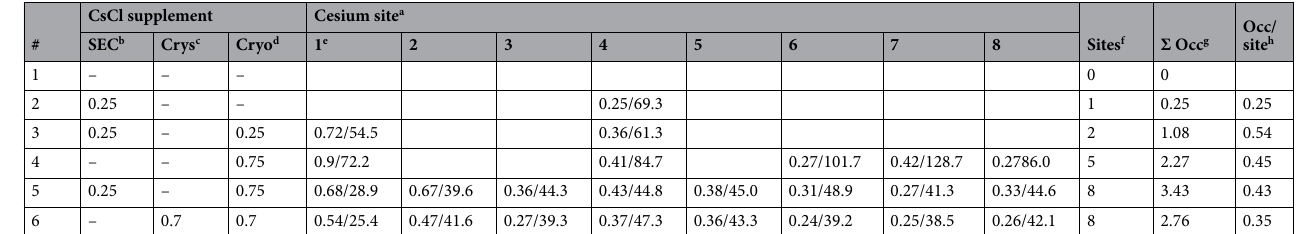
Table 10. Occurrence, occupancy and B factors of cesium sites in p62 PH for the different datasets. a Occupancy/B factors of observed sites is given. Numbers correspond to sites in Fig. 7. b Supplement of CsCl to SEC buffer in mol/l. c Supplement of CsCl to crystallization condition in mol/l. d Supplement of CsCl to cryo- protectant in mol/l. e Site 1 lies on a crystallographic two-fold axis (Fig. 10). Doubled occupancy is given. f Total number of observed sites. g Sum of occupancies of all observed sites. h Average occupancy per